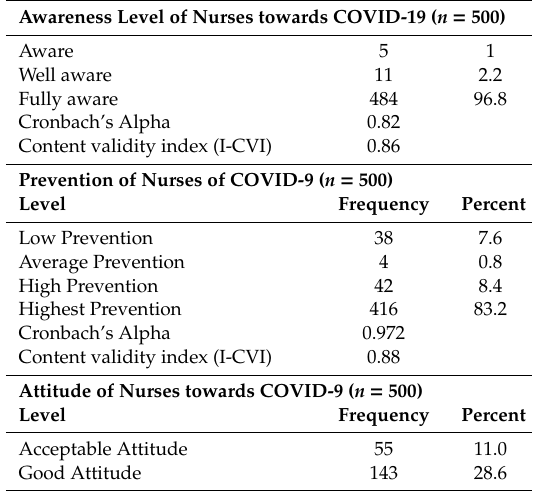
Table 2. Descriptive information of nurses’ awareness, prevention, attitudes, and perceptions during the COVID-19 outbreak in Saudi